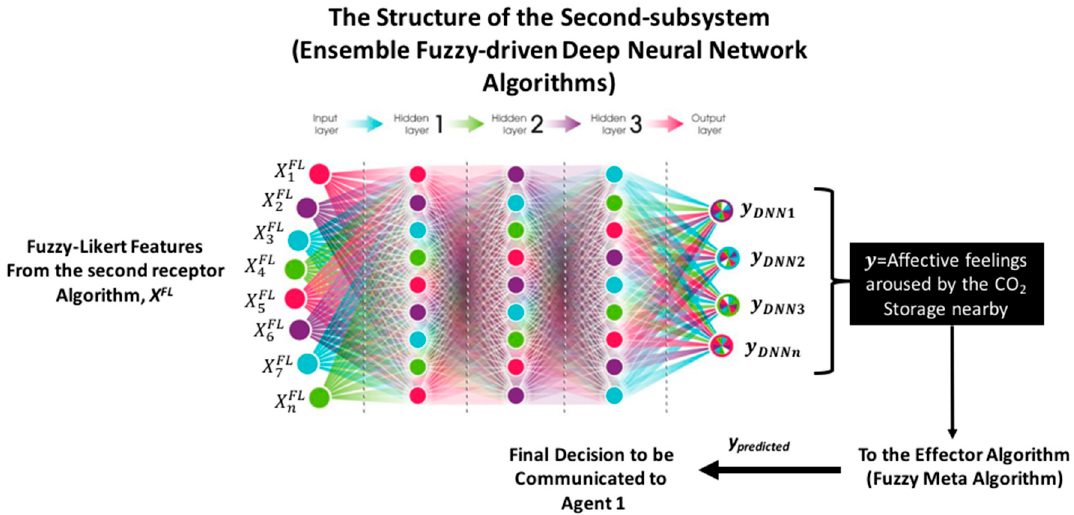
Figure 4. Illustration of how the second subsystem (fuzzy-driven deep neural network) processes the incoming X FL features using the deep neural network’s capability.